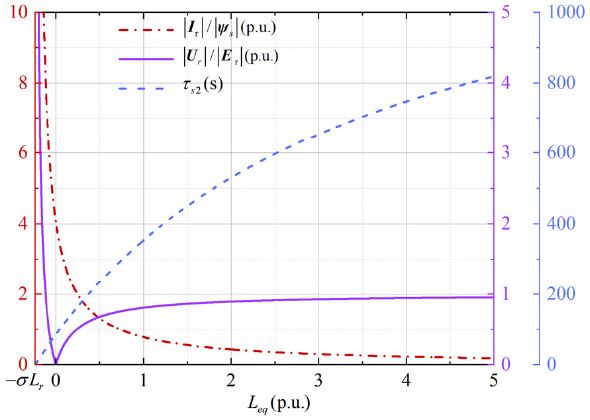
Figure 6. Relationship between L eq and rotor port current, voltage, the time constant of stator flux.